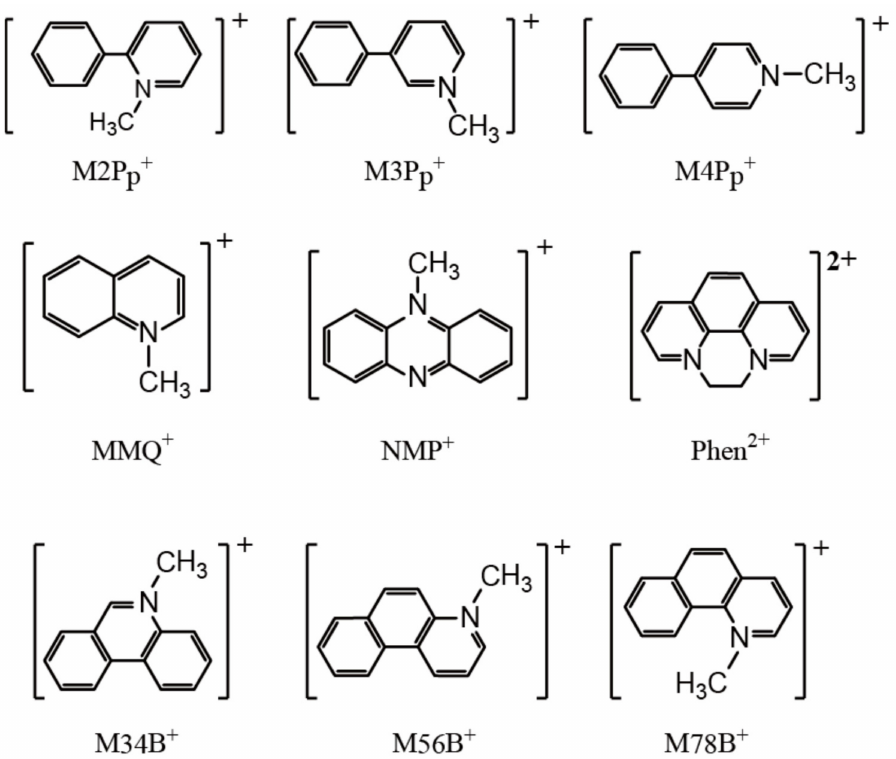
Figure 18. Cations examined in the syntheses of the [Au(dmit) 2 ] − salts. MnPp + = N -methyl n -phenylpyridinium( n = 2–4), NMQ + = N -methylquinolinium, NMP + = N -methylphenazinium, Phen 2 + = N , N (cid:48) -ethylene 1,10-phenanthrolinium, M34B + = N -methyl 3,4-benzoquinolinium, M56B + = N -methyl 5,6-benzoquinolinium, M78B + = N -methyl